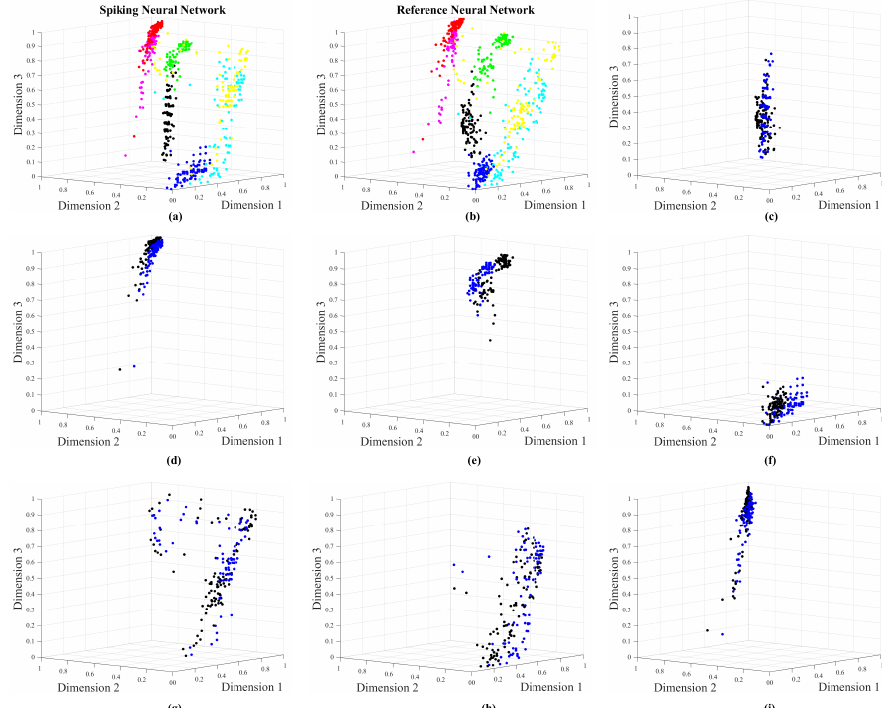
Figure 13. Class distribution for the Cropland Database. In Figure 13a,b, each color represents a class. In Figure 13c–i the blue color corresponds to the SNN distribution and the black color to the reference continuous-sigmoid neural network distribution. ( a ) Distribution from SSN architecture. ( b ) Distribution from Reference Continuous Neuron. ( c ) Corn class. ( d ) Peas class. ( e ) Canola class. ( f ) Soybeans class. ( g ) Oats class. ( h ) Wheat class. ( i ) Broad-Leaf class.